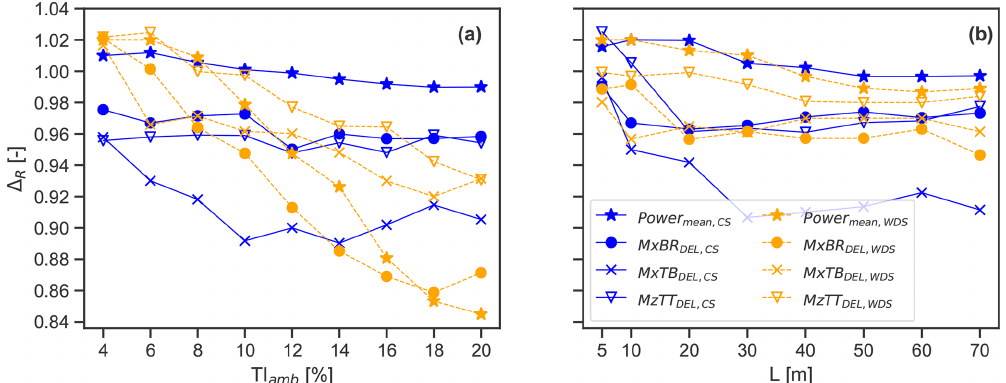
Figure 16. Influence of atmospheric turbulence conditions on the lidar-based load prediction accuracy, including (a) the effect of ambient turbulence ( T amb ) given U amb = 6ms − 1 and (b) the effect of turbulence length scale, L , given U amb = 6ms − 1 and TI amb = 8%. The bias (cid:49) R at each nominal value is computed from 18 simulated field realizations. The Grid pattern is used for the analysis.